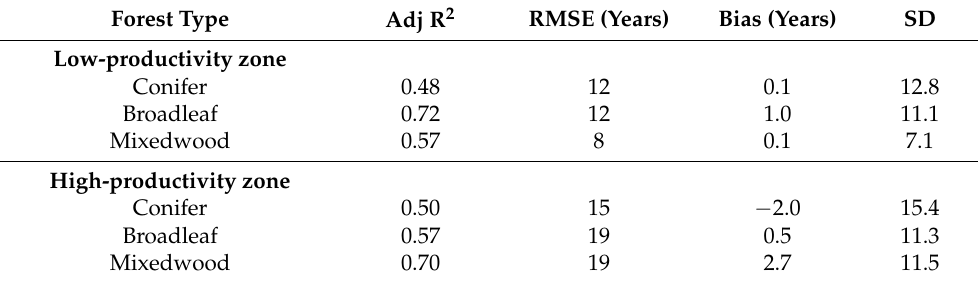
Table 7. Five-fold cross validation of stand age models. Adj. R 2 , adjusted R 2 . RMSE, root mean square error. Bias, mean error (computed as model estimate minus observation). SD, standard